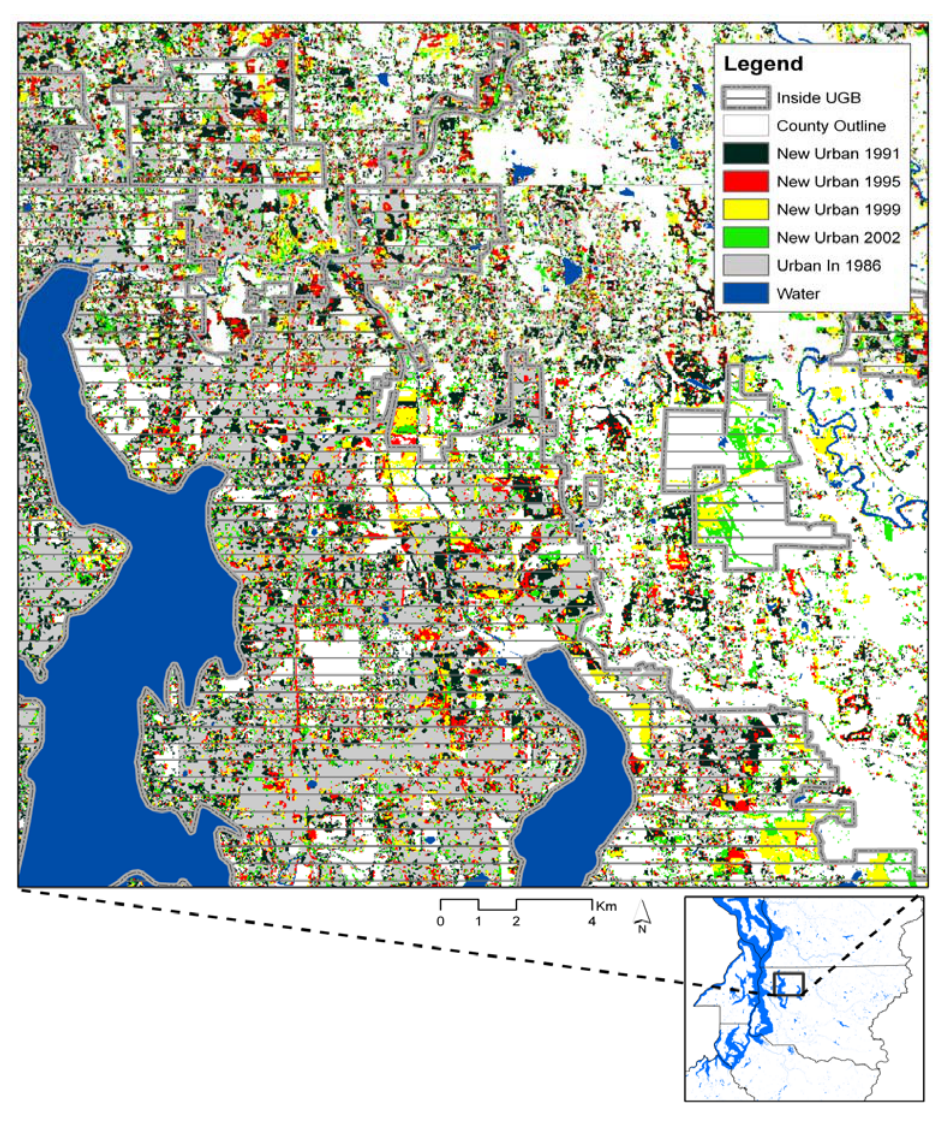
Figure 3. Urban land cover from 1986 to 2002 showing when land transitioned to urban classes with respect to the 2002 Urban Growth Boundaries